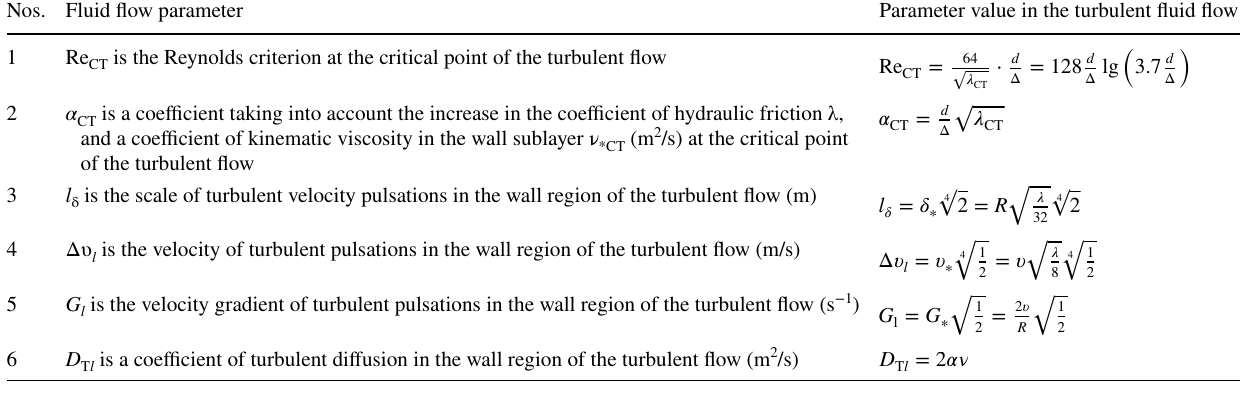
Table 2 The resulting mathematical relationships Nos. Fluid flow parameter Parameter value in the turbulent fluid